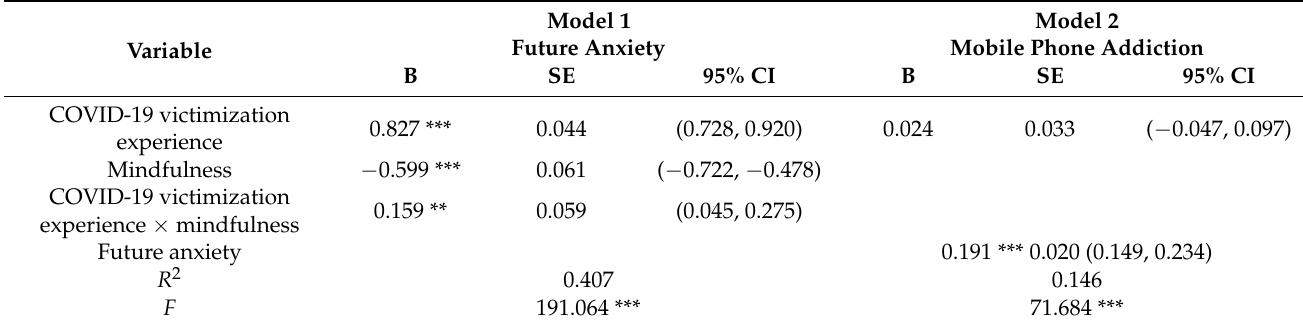
Table 8. Testing the moderated mediation model.